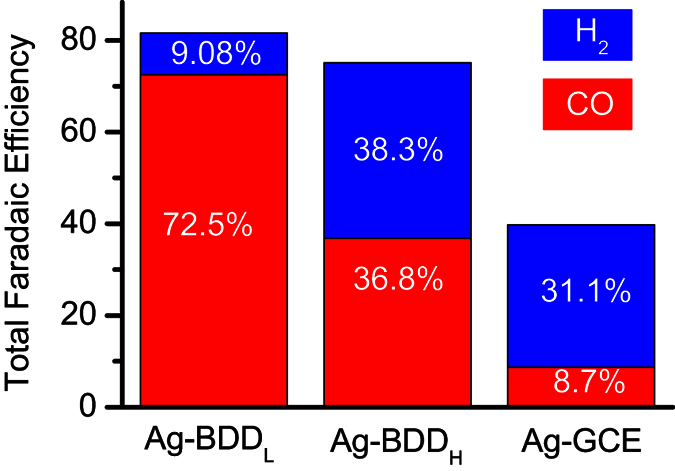
Selectivity of different carbon electrodes.Ag was deposited on BDDL, BDDH and GCE in 0.1 M AgNO3 at −0.5 V for 60 s. Total Faradaic efficiency was measured after 3 h of photoelectrolysis at −1.1 V in 25 mM Na2SO4 under an excimer lamp (222 nm, 7 W).